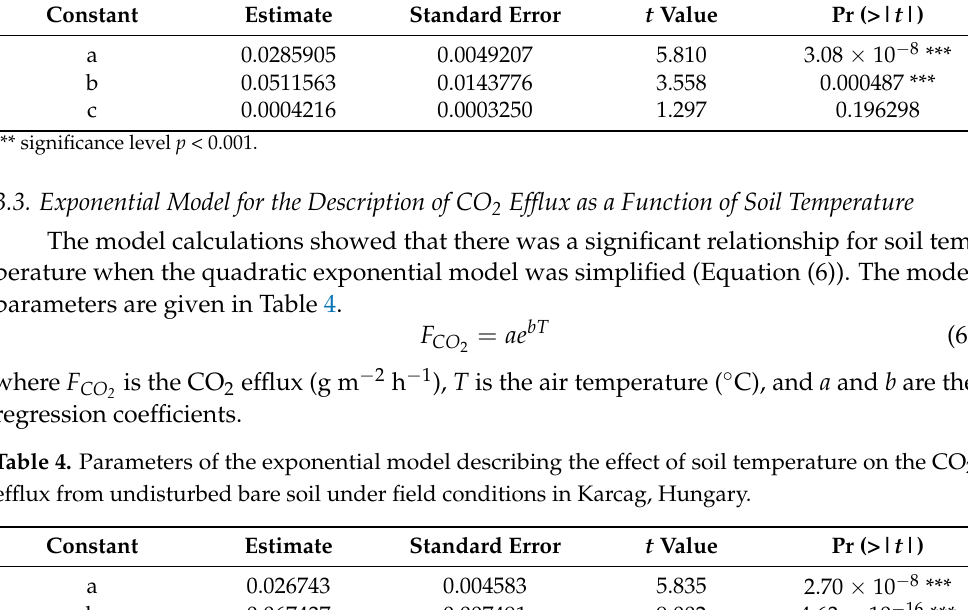
Table 3. Parameters of the quadratic exponential model describing the effect of soil temperature on the CO 2 efflux from undisturbed bare soil under field conditions in Karcag, Hungary. Constant